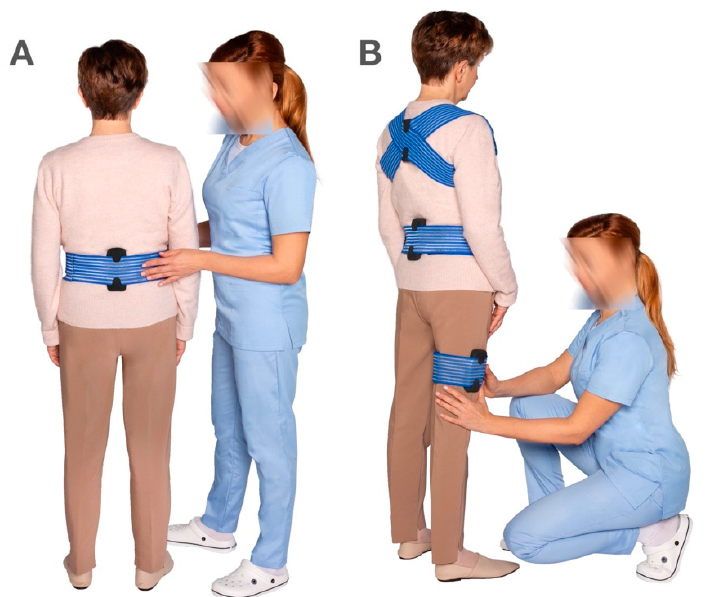
Figure 1. ( A )—The MediPost device mounted in the lumbar area for single-sensor measurement, ( B )—multiple MediPost sensors mounted on the trunk, lumbar area, and limbs for multi-sensor measurements.